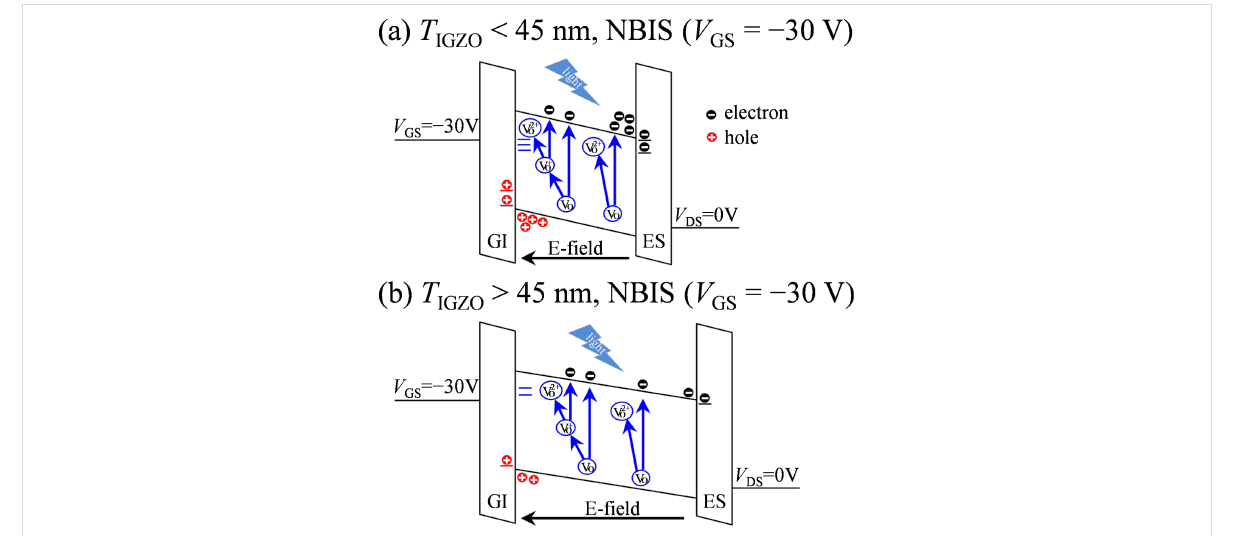
Figure 6: Schematic diagram of NBIS-induced degradation mechanism in a-IGZO TFTs with (a) T IGZO < 45 and (b) over the Debye length (75 and 100 nm).